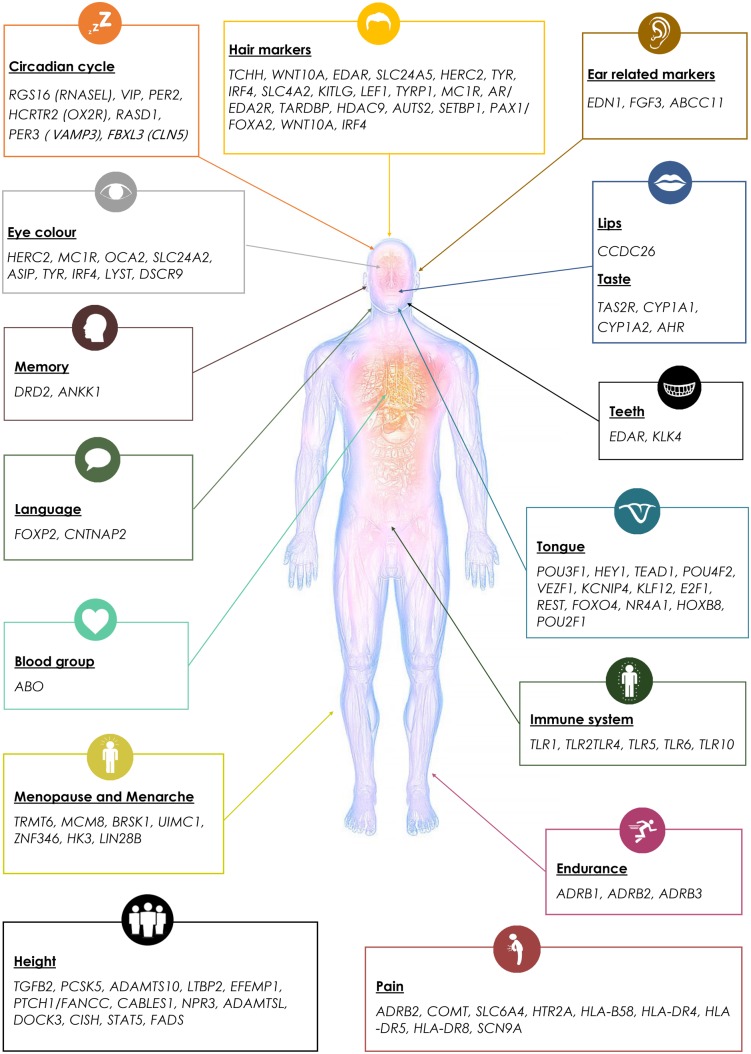
—Human traits and their associated genetic loci.